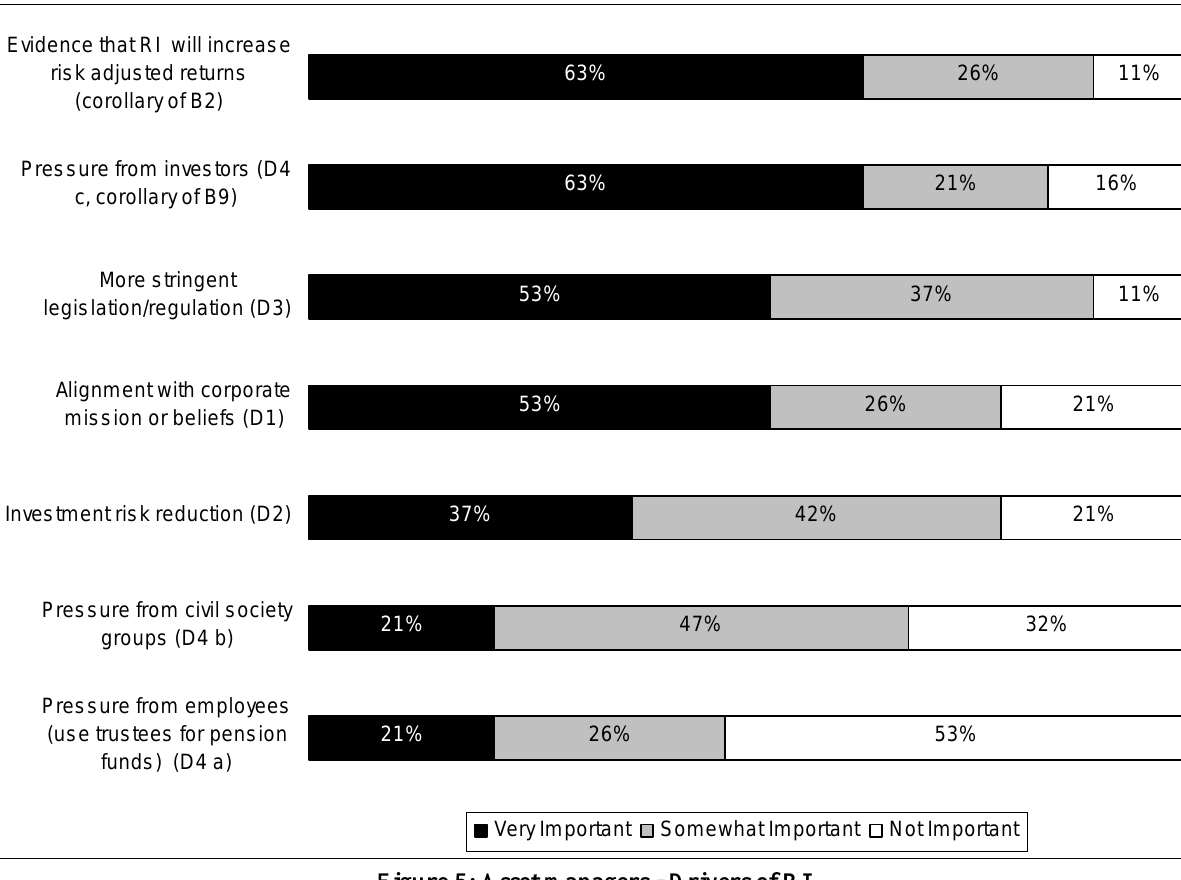
Figure 5: Asset managers - Drivers of RI